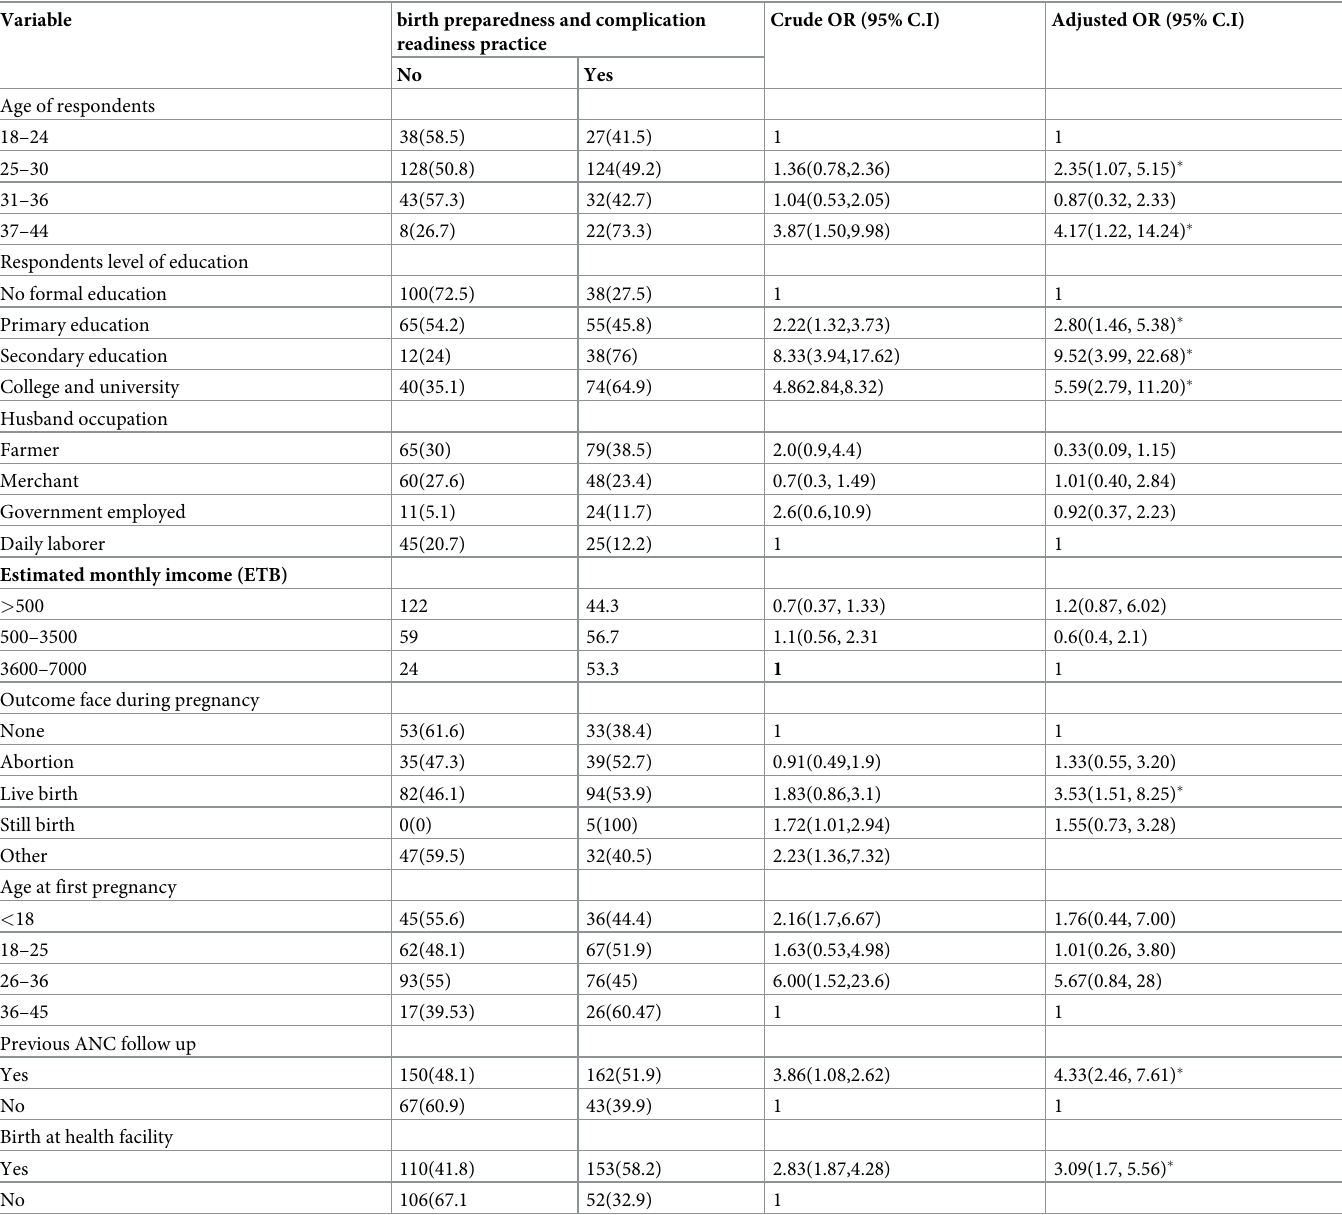
Table 3. Factors affecting birth preparedness and complication readiness practice in Yirgalem general Hospital, Sidama Zone, Ethiopia; 2019 (n =